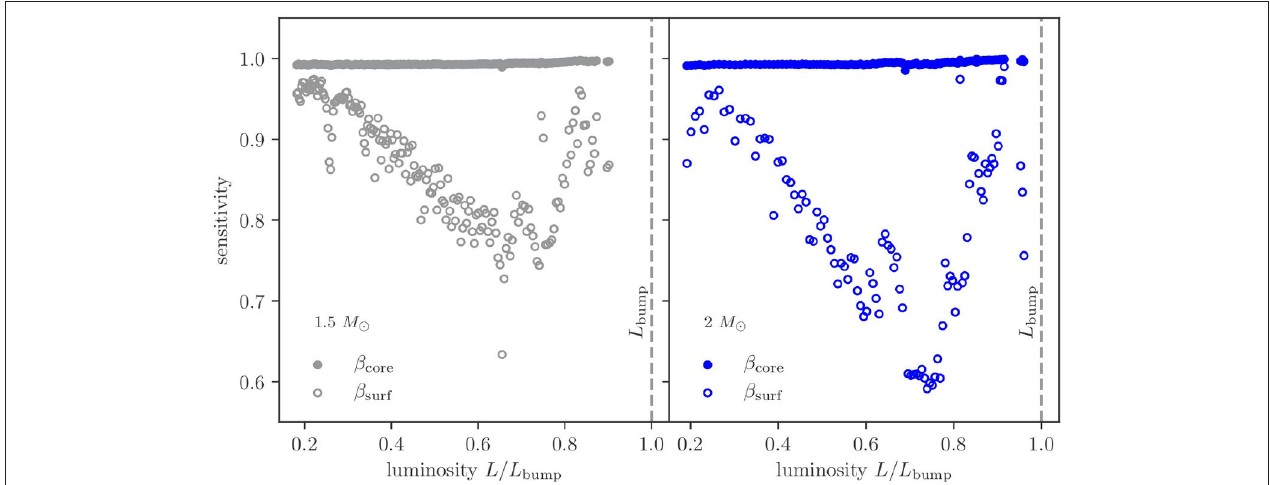
(Left) and 2.0 M (Right) obtained using dipole mode ⊙ ⊙ r core 0 K ( r 0 , r ) dr , where K ( r 0 , r ) is the averaging kernel and = r lim K ( r 0 , r ) dr , r lim 0.98 R star ) is shown as open circles. The vertical dashed lines 1 0 R = = − R